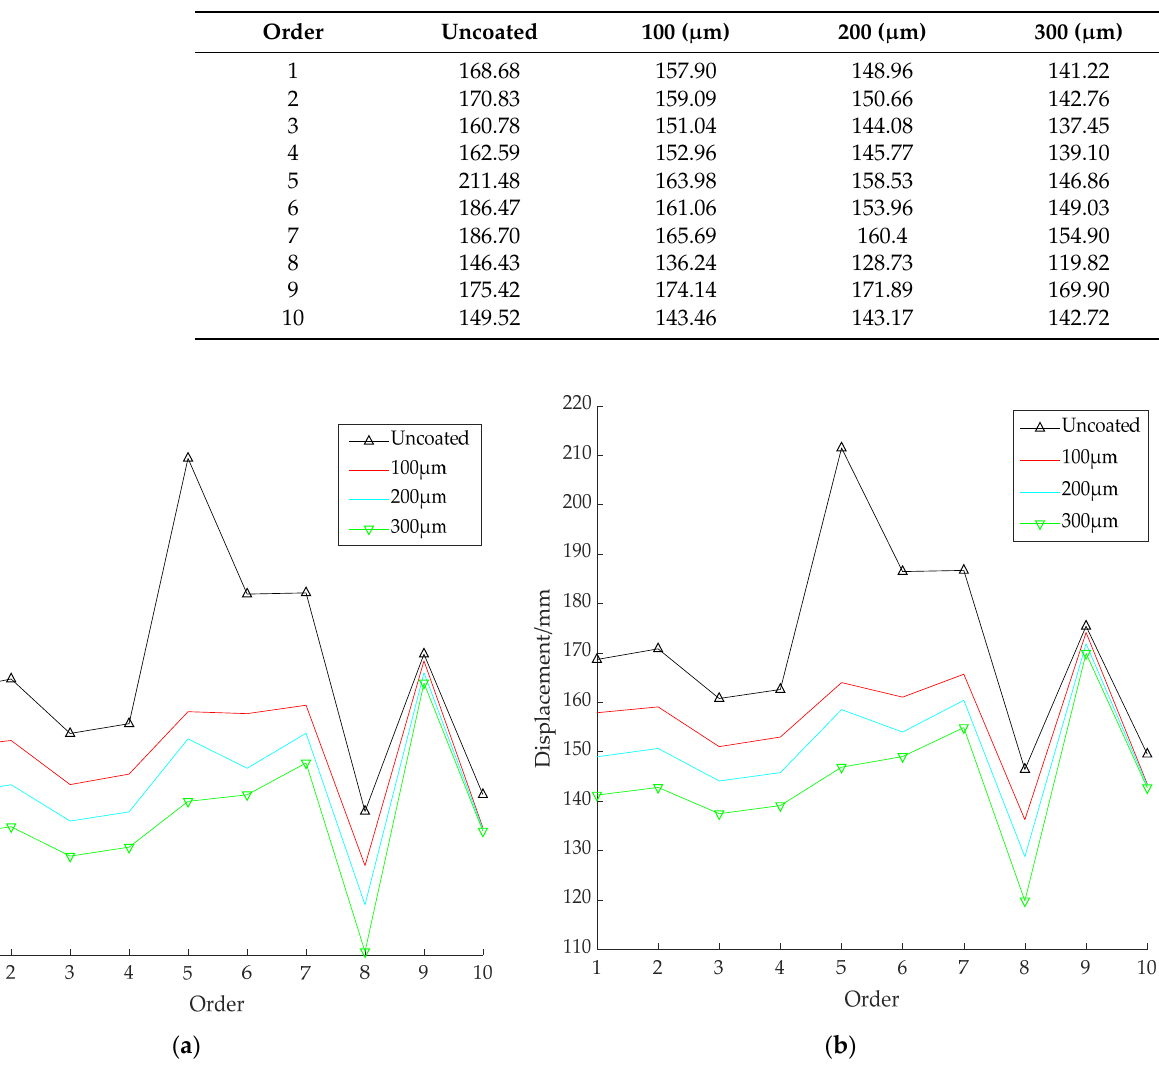
Table 9. Maximum deformation of the main vibration mode of the TA18 titanium alloy straight aviation hydraulic pipe coated with the YSZ–PTFE coating at different coating thicknesses (mm).